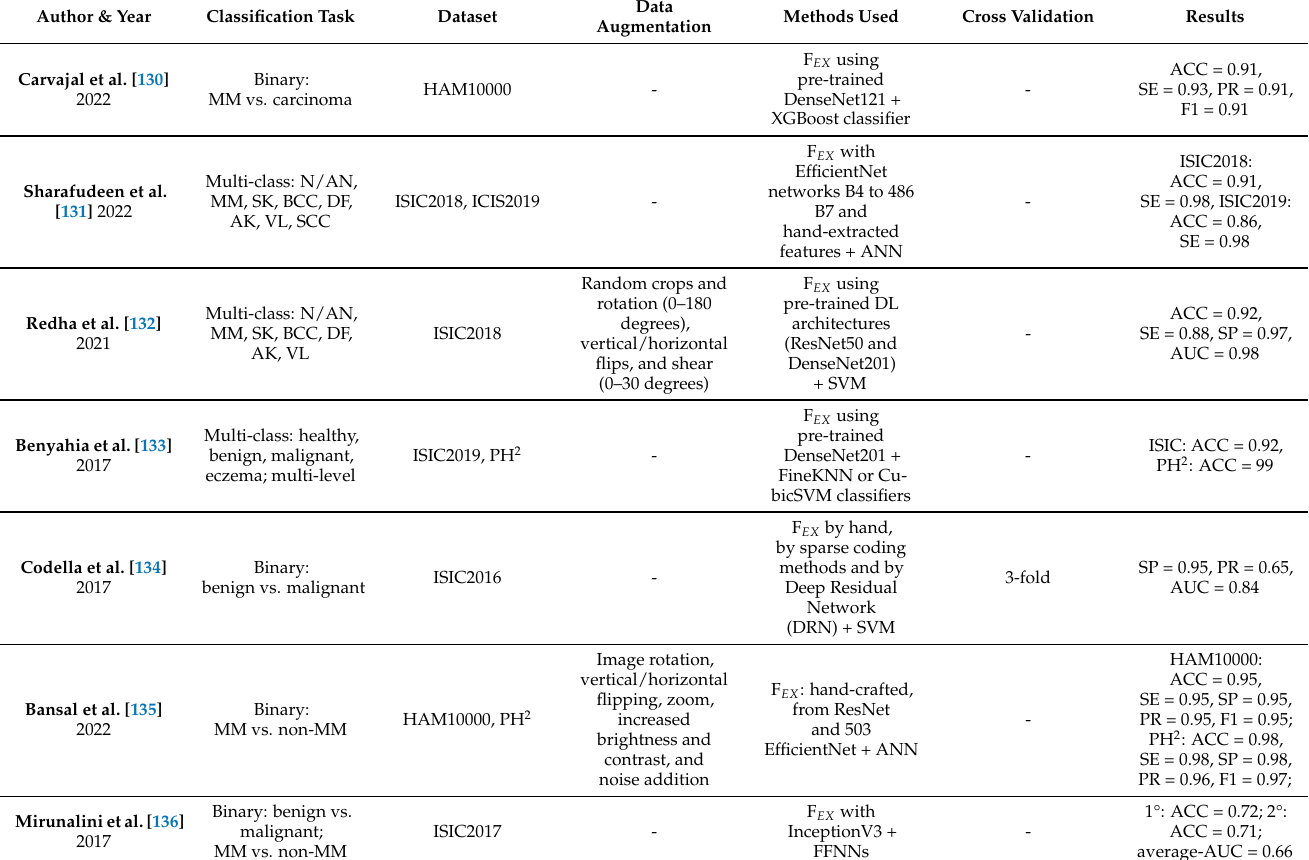
Table 6. Overview of cited works using ML/DL hybrid approaches (results have been rounded). F EX and F SE abbreviations are used for feature extraction and selection, respectively. The symbol “-” indicates that no information is provided on a particular